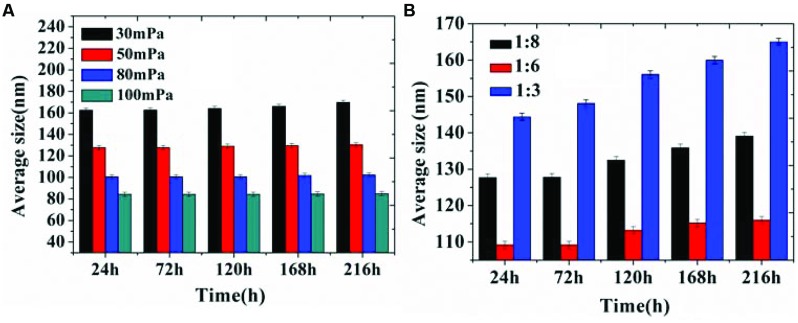
Storage stability of organogel-nanoemulsion prepared under different pressures (A) and SORs (B) at 28°C.